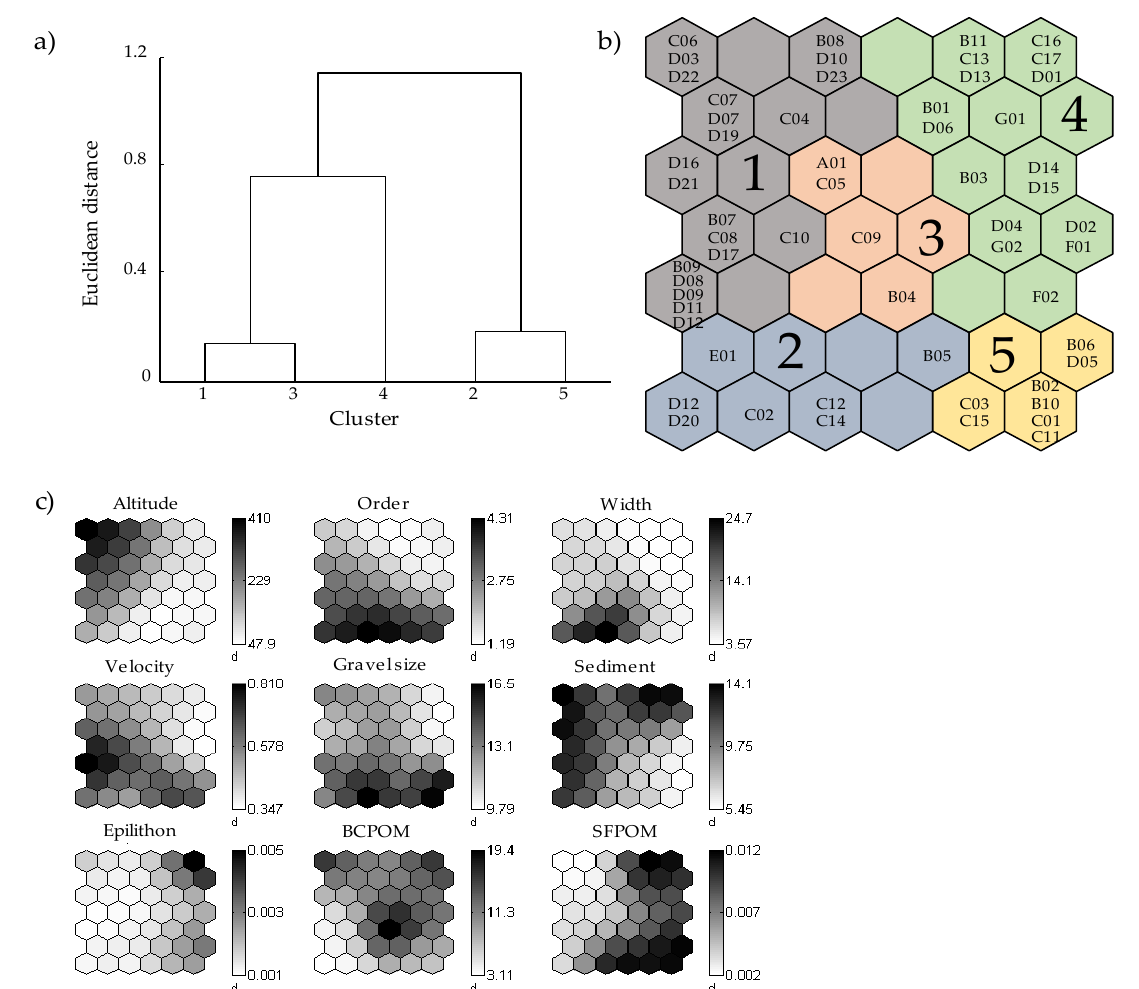
Figure 3. Patterning of sampling sites with SOM according to natural environmental factors. Dendrogram ( a ); ordination map ( b ); and component plane ( c ). The code in each node of map ( b ) refers to the name of sampling sites shown in Figure 1. Gray levels in ( c ) indicate the mean value of each variable, corresponding with sampling units presented on output nodes of SOM. Mean gravel size was calculated as the mean of the longest diameter among 36 grid points sampled in a 1 m 2 area of the stream bottom in riffles [8].